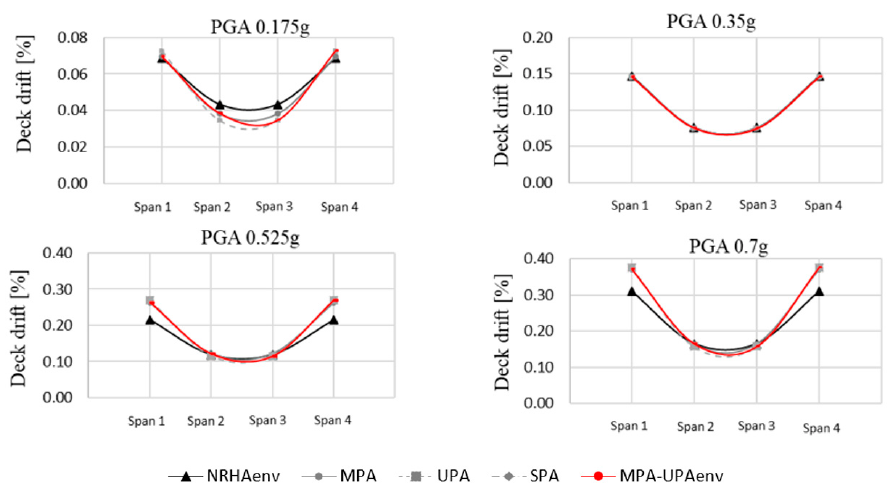
Figure 17. Regular bridge—deck drift (relative displacement between two consecutive joints P i and P i + 1 / P i -P i + 1 span length) derived by performing nonlinear dynamic analysis and pushover analysis according to the approaches considered (PGA 0.175–0.7 g).